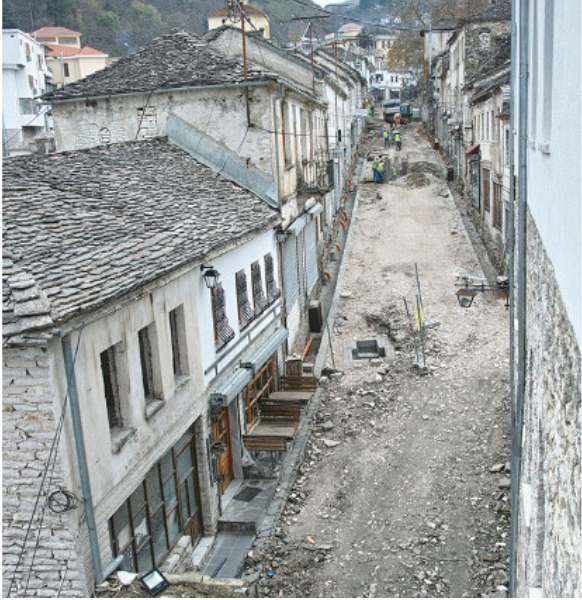
Figure 2. Gjirokastra roads being restored (© M. Carta, 2019).